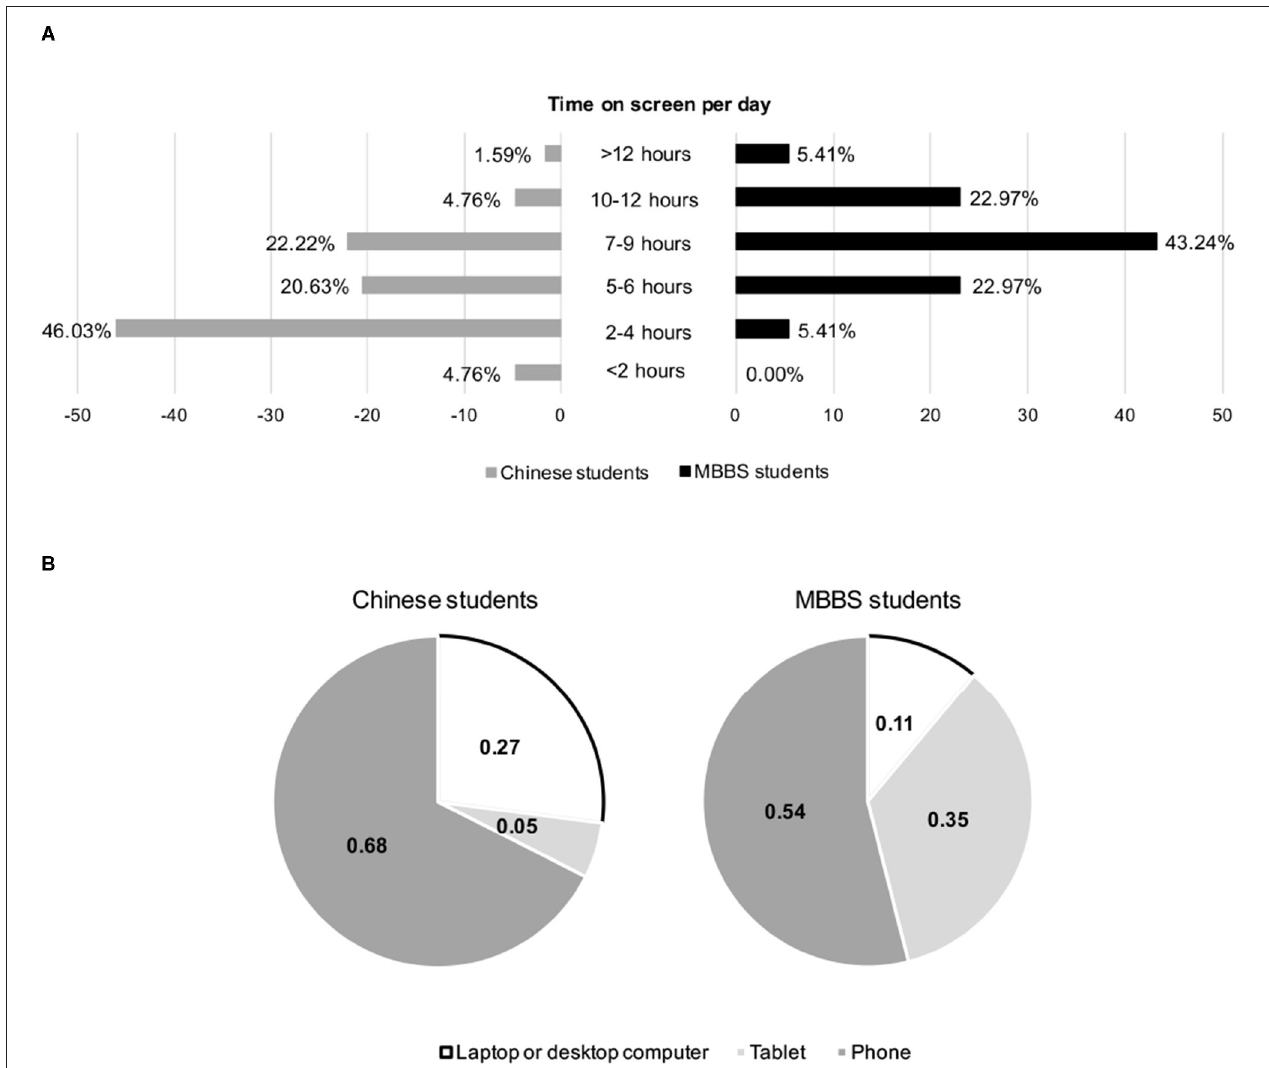
FIGURE 1 | Digital screen time and the use of digital terminals among responders. (A) Comparison of average digital screen time per day between Chinese and MBBS students; (B) comparison of the most often used digital terminals between Chinese and MBBS students. users of digital terminals (screen time ≥ 10 h per day) were